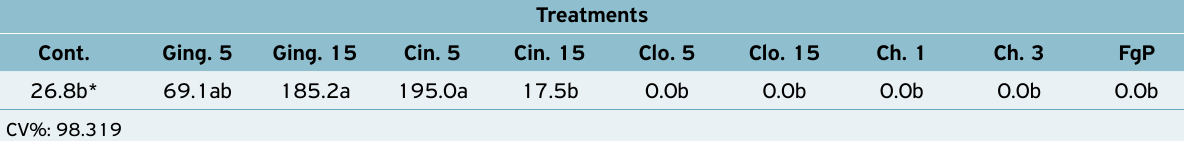
Table 1. Sporulation, expressed by the number of C . gloeosporioides conidia (× 10 4 conidia.mL ‑1 ) under different treatments: control (Cont.); 5% ginger (Ging. 5); 15% ginger (Ging.15); 5% cinnamon (Cin. 5); 15% cinnamon (Cin. 15); 5% clove (Clo. 5); 15% clove (Clo. 15); 1% chitosan (Ch. 1); 3% chitosan (Ch. 3), and fungicide Prochloraz at 100 μ g.mL ‑1 (FgP). Dourados, Mato Grosso do Sul, UFGD,